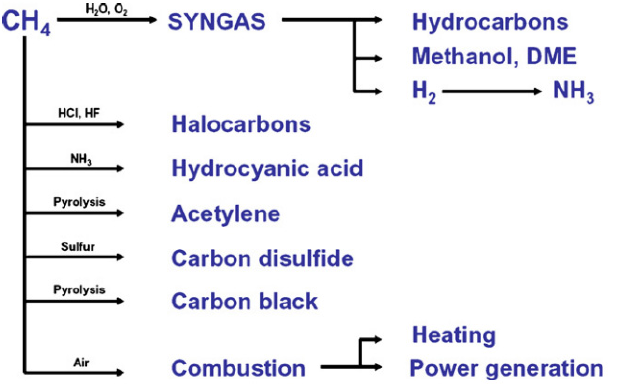
Figure 2. Utilization of methane in industries [3]. Reproduced with permission from Holmen. Copyright © 2022 Elsevier.